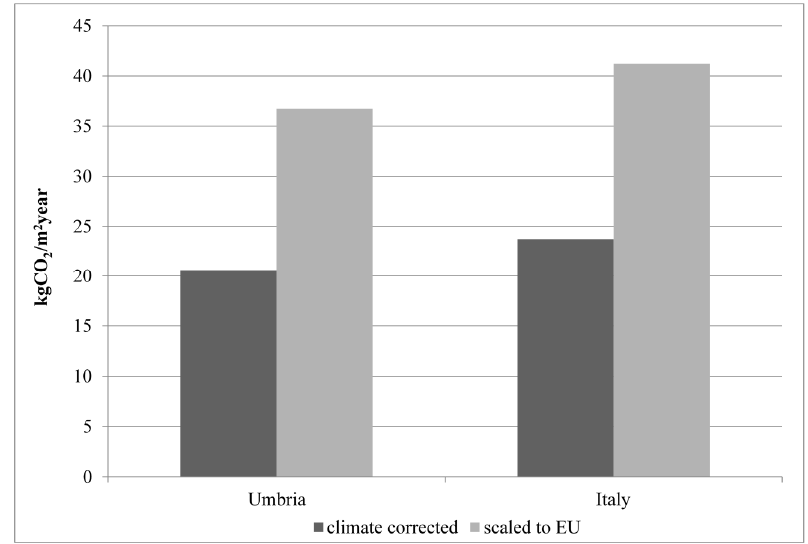
Figure 8. Average CO 2 emissions per useful floor area for Umbria and Italy: comparison between climate corrected and EU scaled